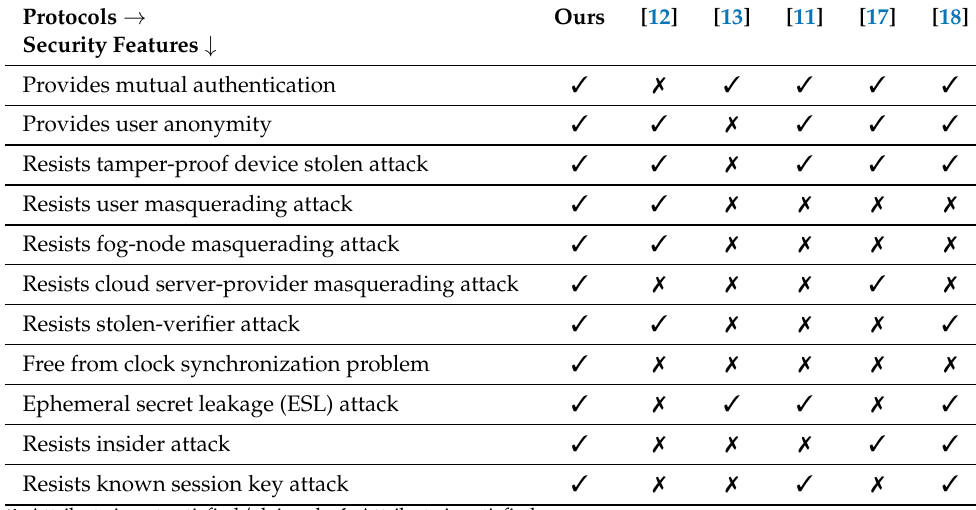
Table 6. V of security and